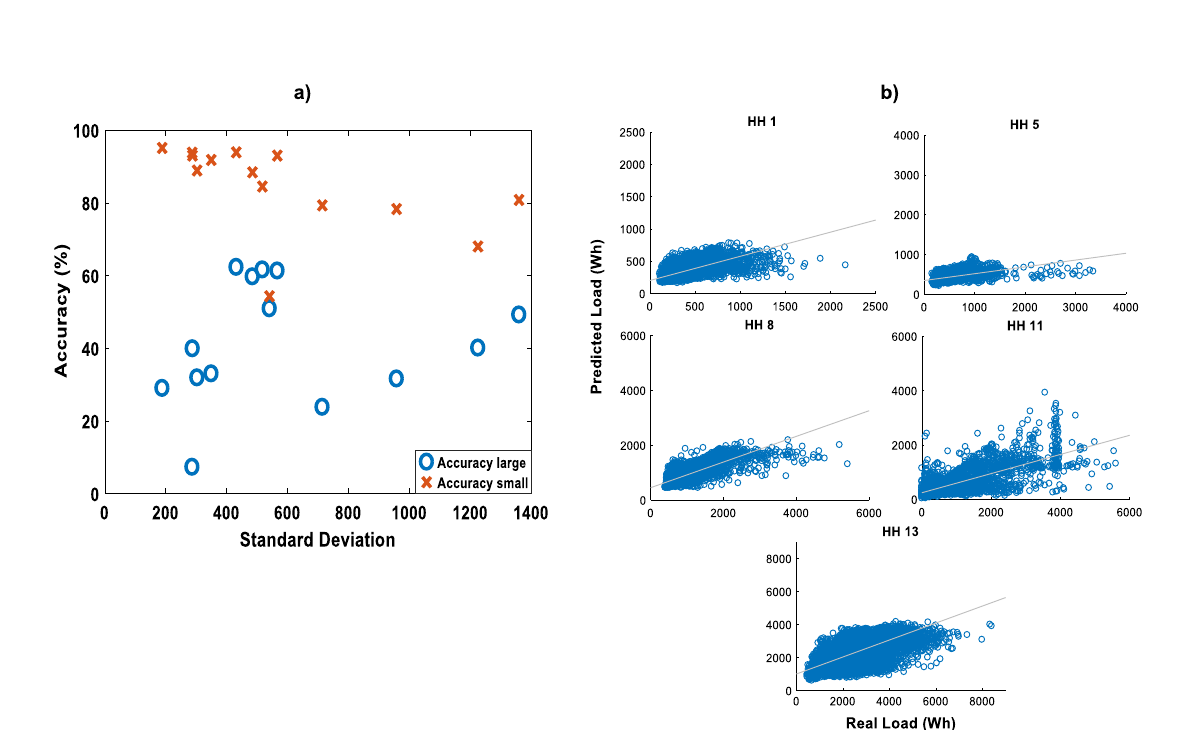
Fig. 3. (a) Accuracy metrics versus standard deviation. (b) Real vs. predicted loads at hourly resolution and 24 h-ahead horizon by SVR for 5 representative households.